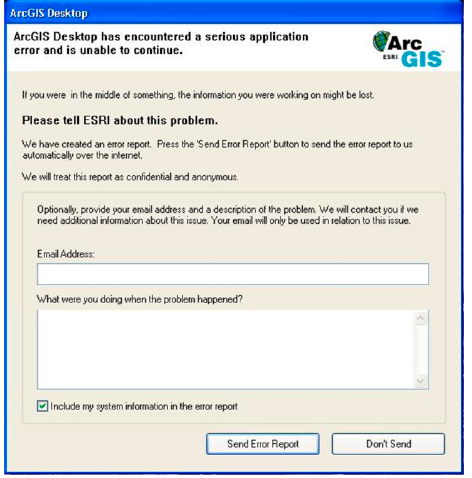
Figure 4. ArcGIS crashes when reading data with misinterpretation on metadata.